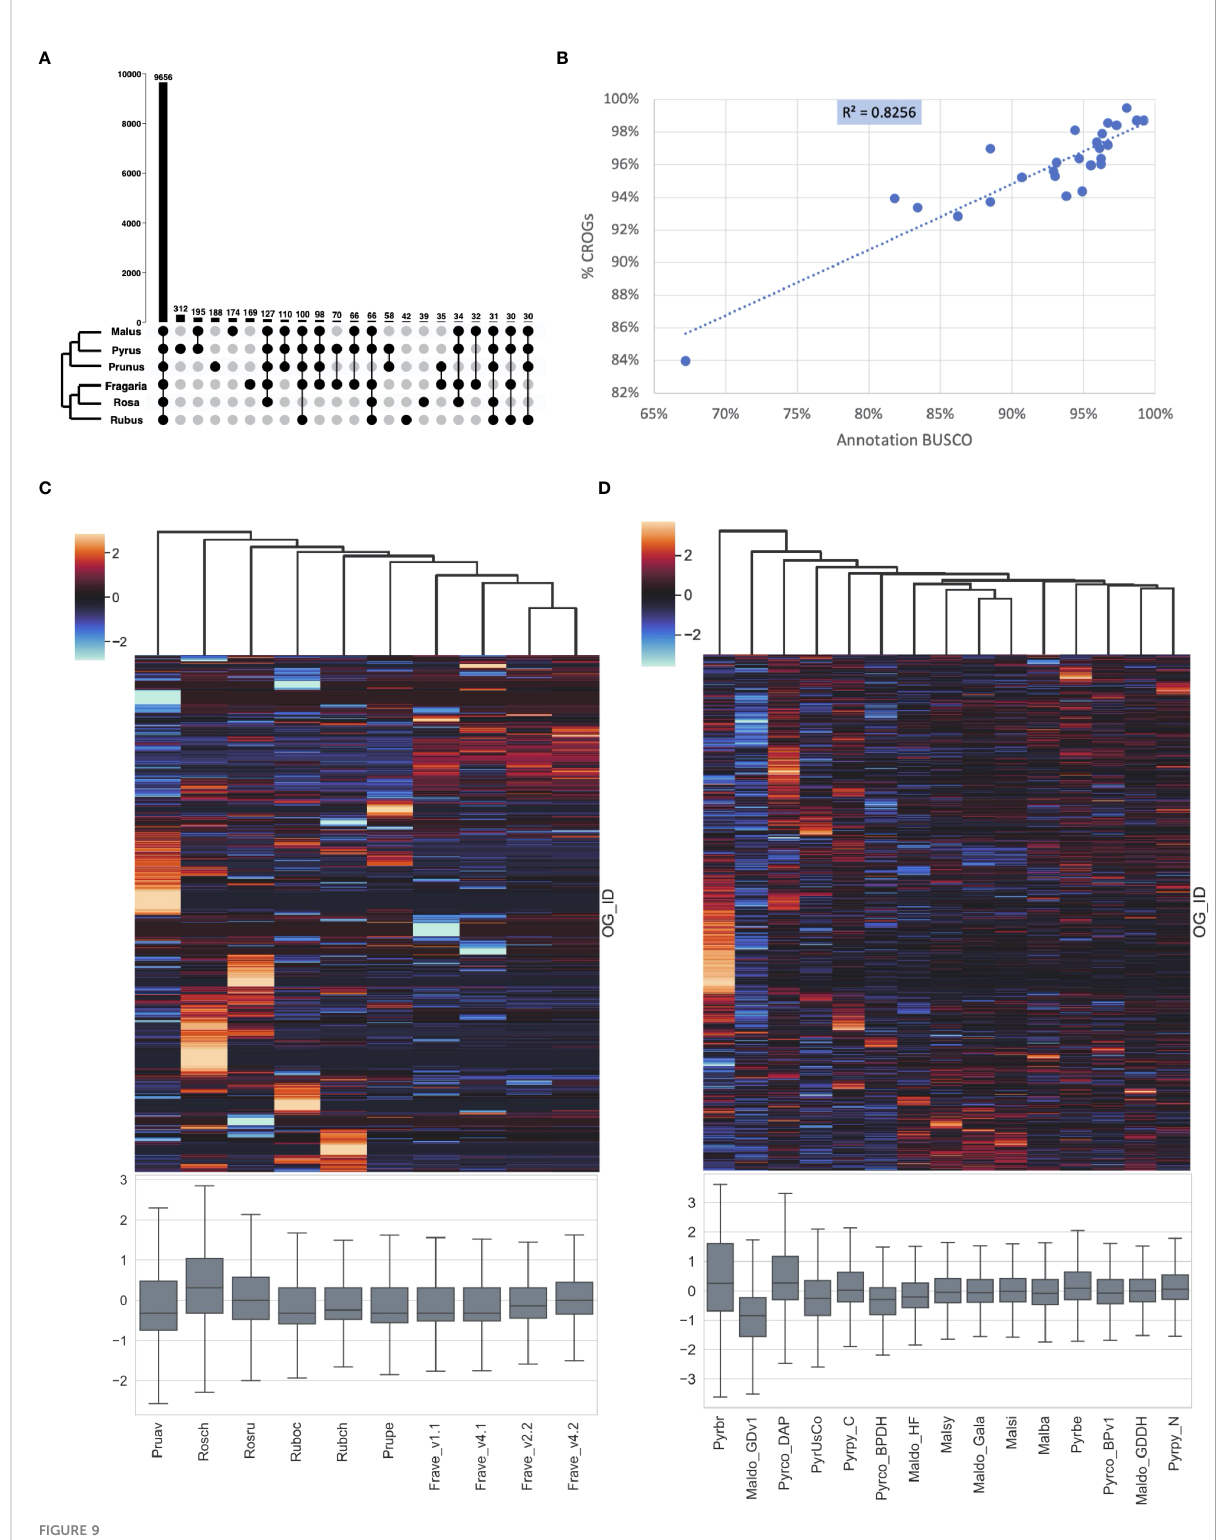
FIGURE 9 CoRe OrthoGroups - Rosaceae (CROGs). (A) Upset plot showing overlapping orthogroups between six Rosaceae genera, including 9656 orthogroups shared by all six genera (designated as “ CROGs – Rosaceae ” ). (B) High correlation between Rosaceae genome annotation BUSCOs and % CROGs captured in the genomes (p<0.01). (C) Z-score distribution of gene counts in CROGs among selected Rosaceae genomes excluding Malus and Pyrus , shown as a clustermap (upper) and a box plot (lower). Each column represents a genome and each row in the clustermap represents a CROG. (D) Z- score distribution of gene counts in CROGs among selected Malus and Pyrus genomes, shown as a clustermap (upper) and a box plot (lower). Genome abbreviations can be found in Supplemental Table